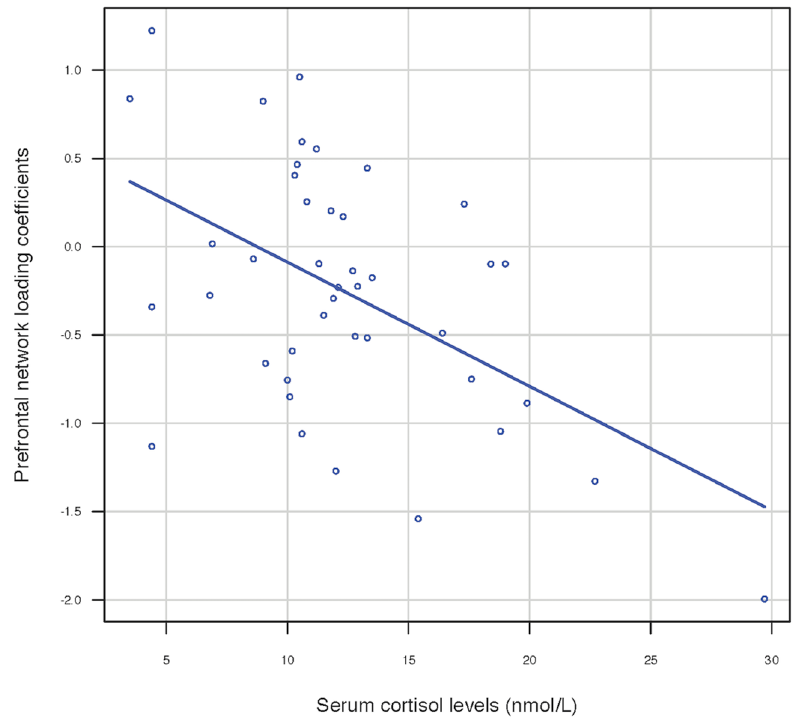
Figure 2. Correlation of cortisol levels and loading coefficients (Z-scores) of the prefrontal network in MDD patients. Scatter plots of prefrontal network loading coefficients and serum cortisol levels in patients with MDD showed a significant negative linear correlation (r = -0.354, p =